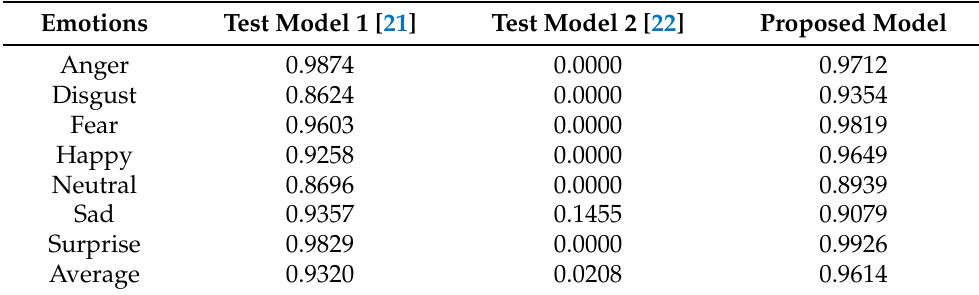
Table 30. Precision comparison between all three models with respect to observation 2 of Experiment 2 with 100